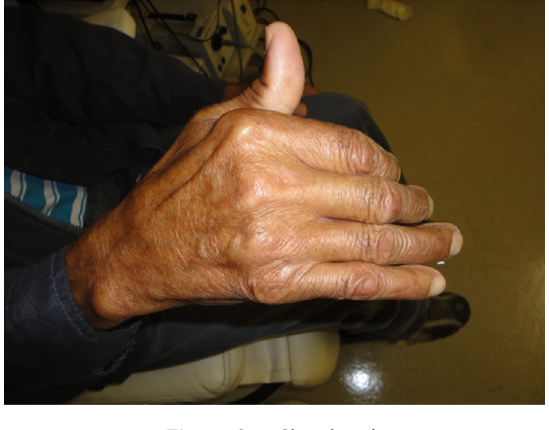
Figure 3 Claw hand. Figure 4 Rimmed vacuoles at the deltoid muscle biopsy (mod- ified Gomori stain, 350 × ).